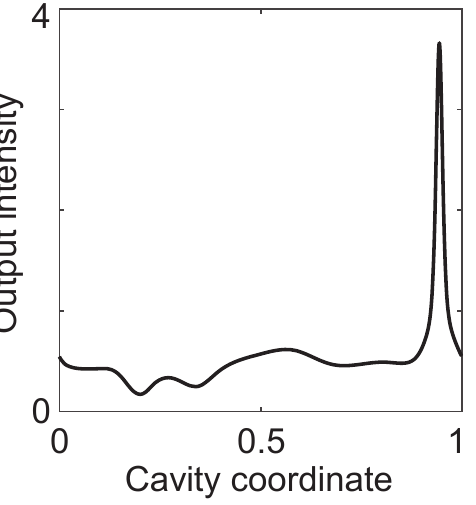
Figure 11: The output intensity profile relative to the simulation of Figure 10(b) shows that a negative hump is present on the left of the cavity, producing an effective negative